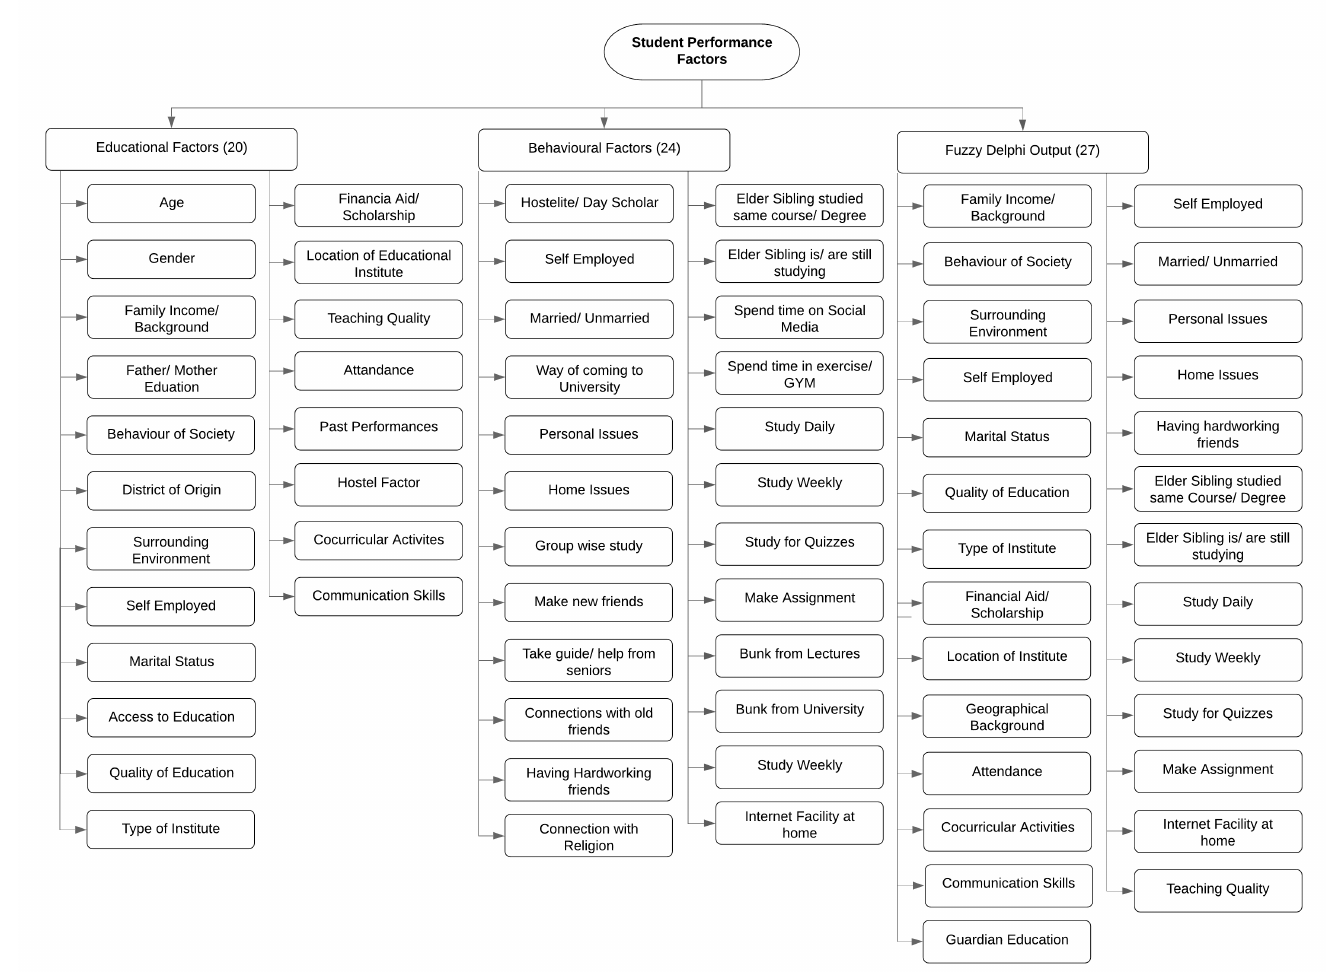
Figure 1. Taxonomy of Systematic Literature Review.